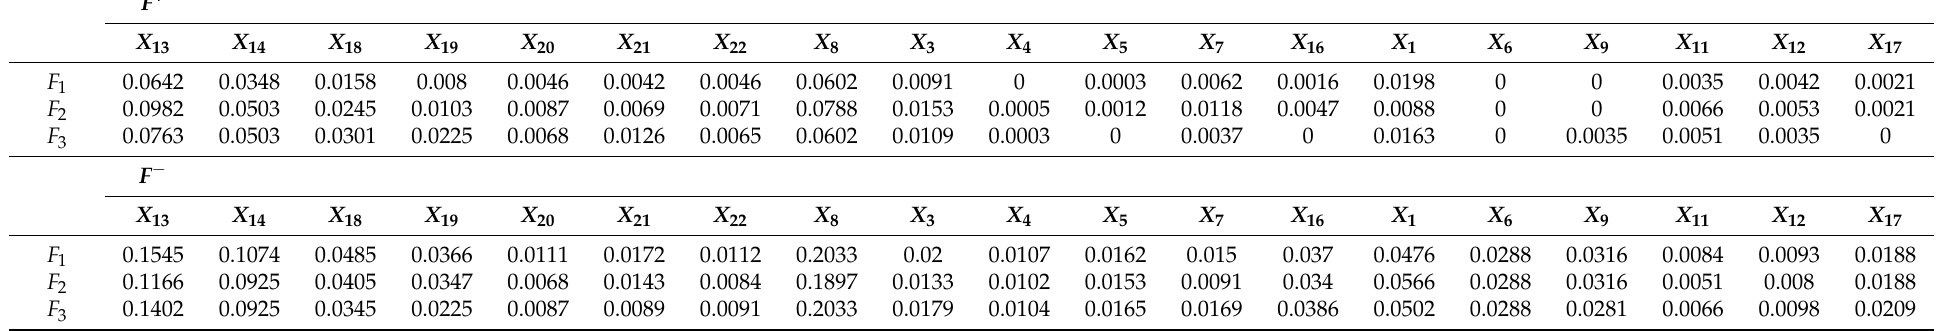
Table 13. Distances in the ratings of each alternative from the FPIS and FNIS